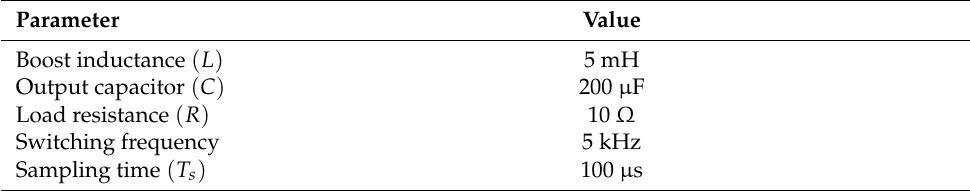
Figure 2. The experimental set-up of the PV system. Table 1. The parameters of the power circuit of the PV